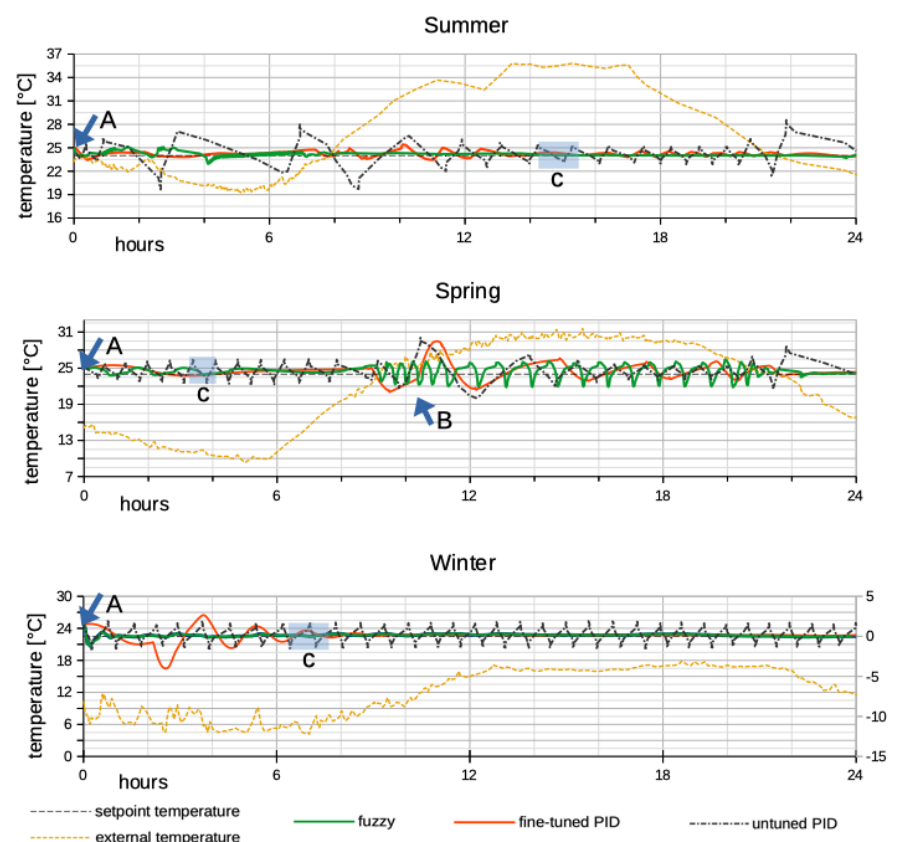
Figure 13. The plots of indoor temperatures and external temperature for example simulated days of every season for a large room. The marked parts: A—the initial temperature and starting overshoot; B—the overshoot during recovery and blending activation; C—the oscillation ranges are discussed in more detail in Section